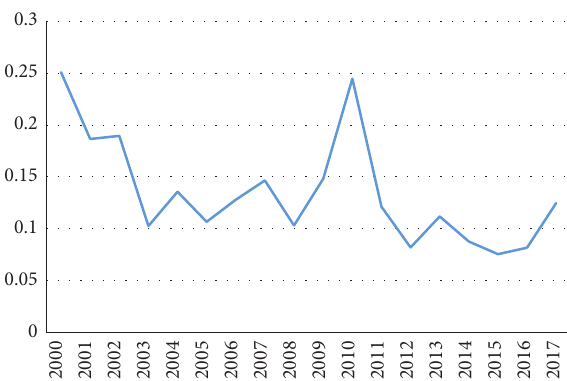
Figure 1: Analysis framework.